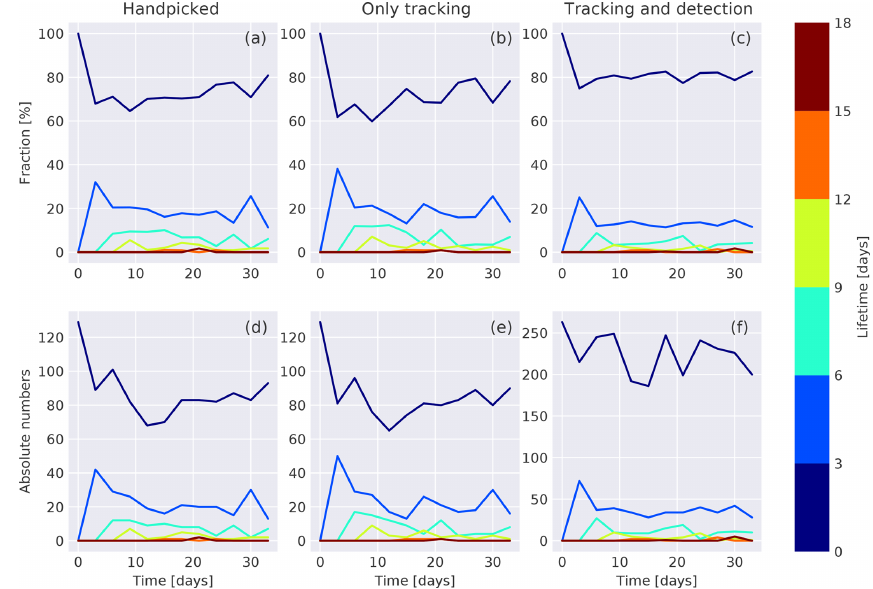
Figure 9. Distribution of lifetime of all features in the first 12 RGPS snapshots in 2006 in the handpicked reference data (a, d) , the automat- ically tracked features of the handpicked features (b, e) , and the automatically tracked features of the automatically detected features (c, f) . Panels (a–c) show the absolute number of features for a certain lifetime class, whereas panels (d–f) are normalized by the total number of features for this time record.